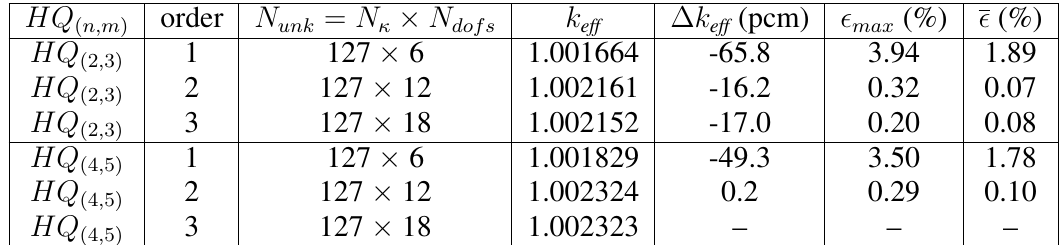
Table 3: Solutions with Wachspress shape